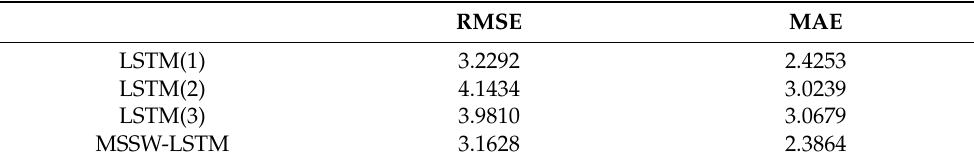
Table 4. Performance comparison of traditional LSTM and proposed MSSW-LSTM.